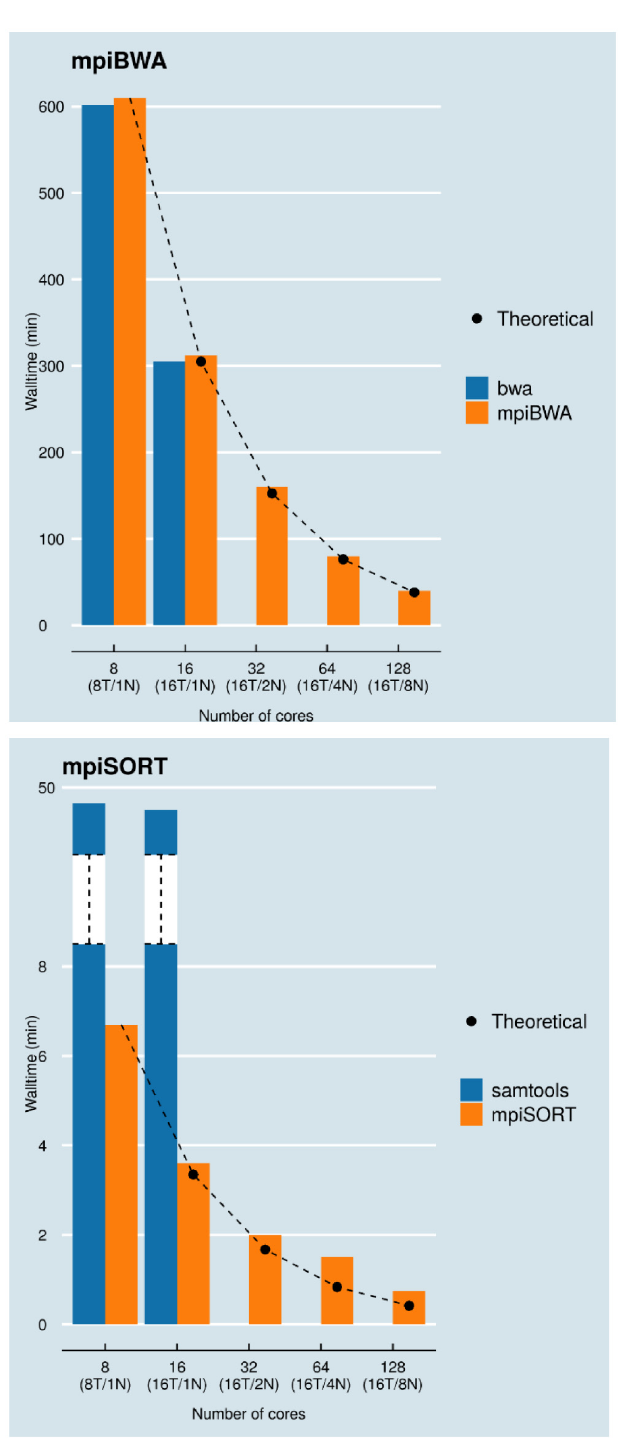
Figure 8. Walltimes for the alignment of the 28X depth of coverage sample and sorting of the chr16 from the 300X depth of coverage sample varying the number of cores. The number in brackets indicates how many threads (T) on how many nodes (N) have been launched, the number of cores used being the product of the two values. The black dots represent the theoretical values of the walltime with respect to the 8 cores value of the MPI implementation being set as the